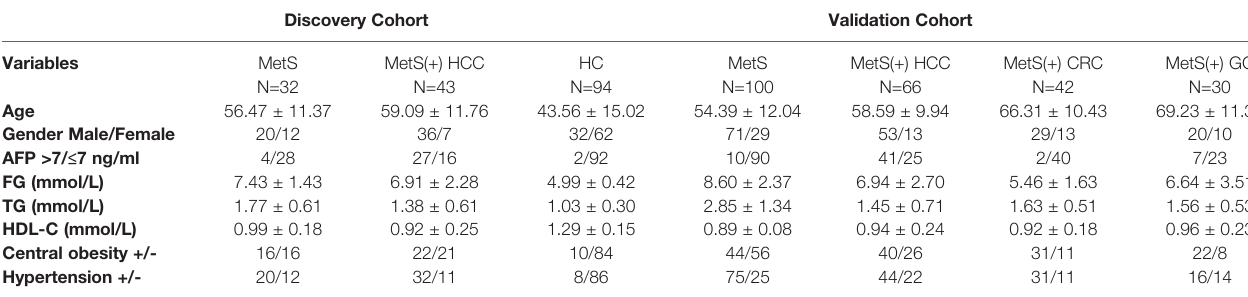
TABLE 1 | The demographic and clinical variables of individuals included in this